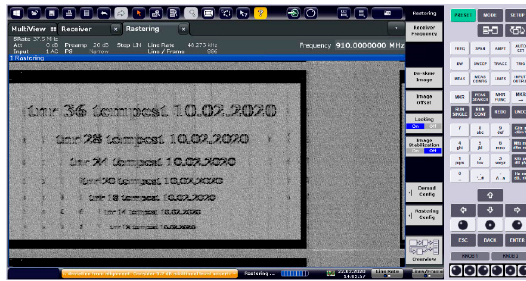
Figure 11. Image recovered with Times New Roman font—R&S FSWT receiver.